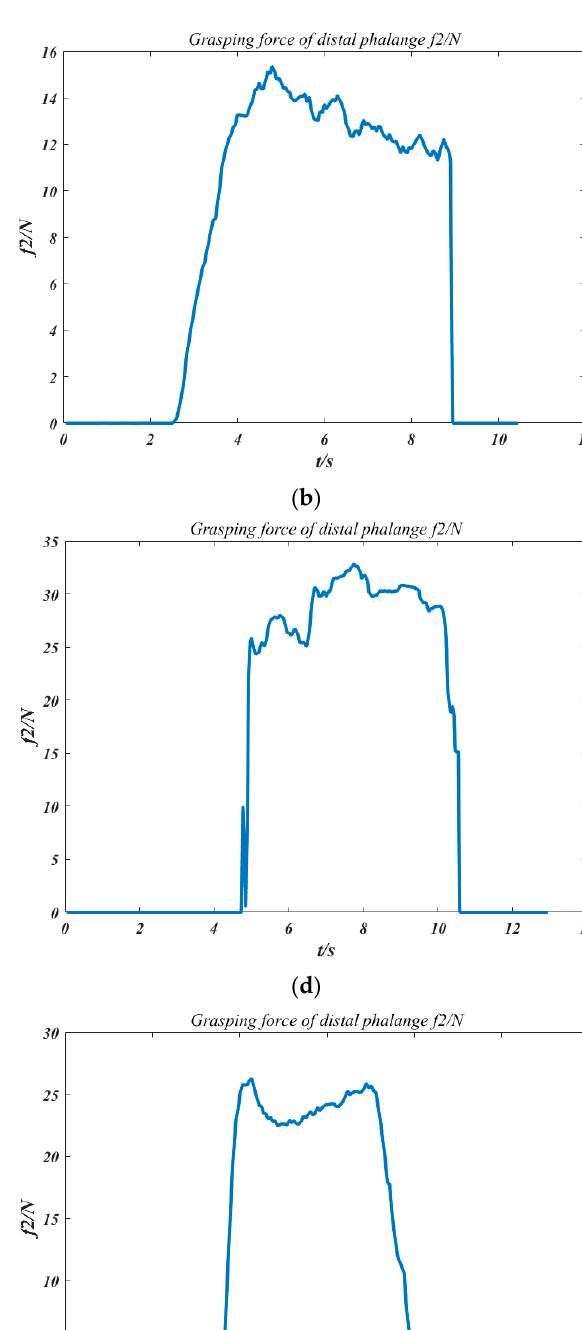
in experiment scenario